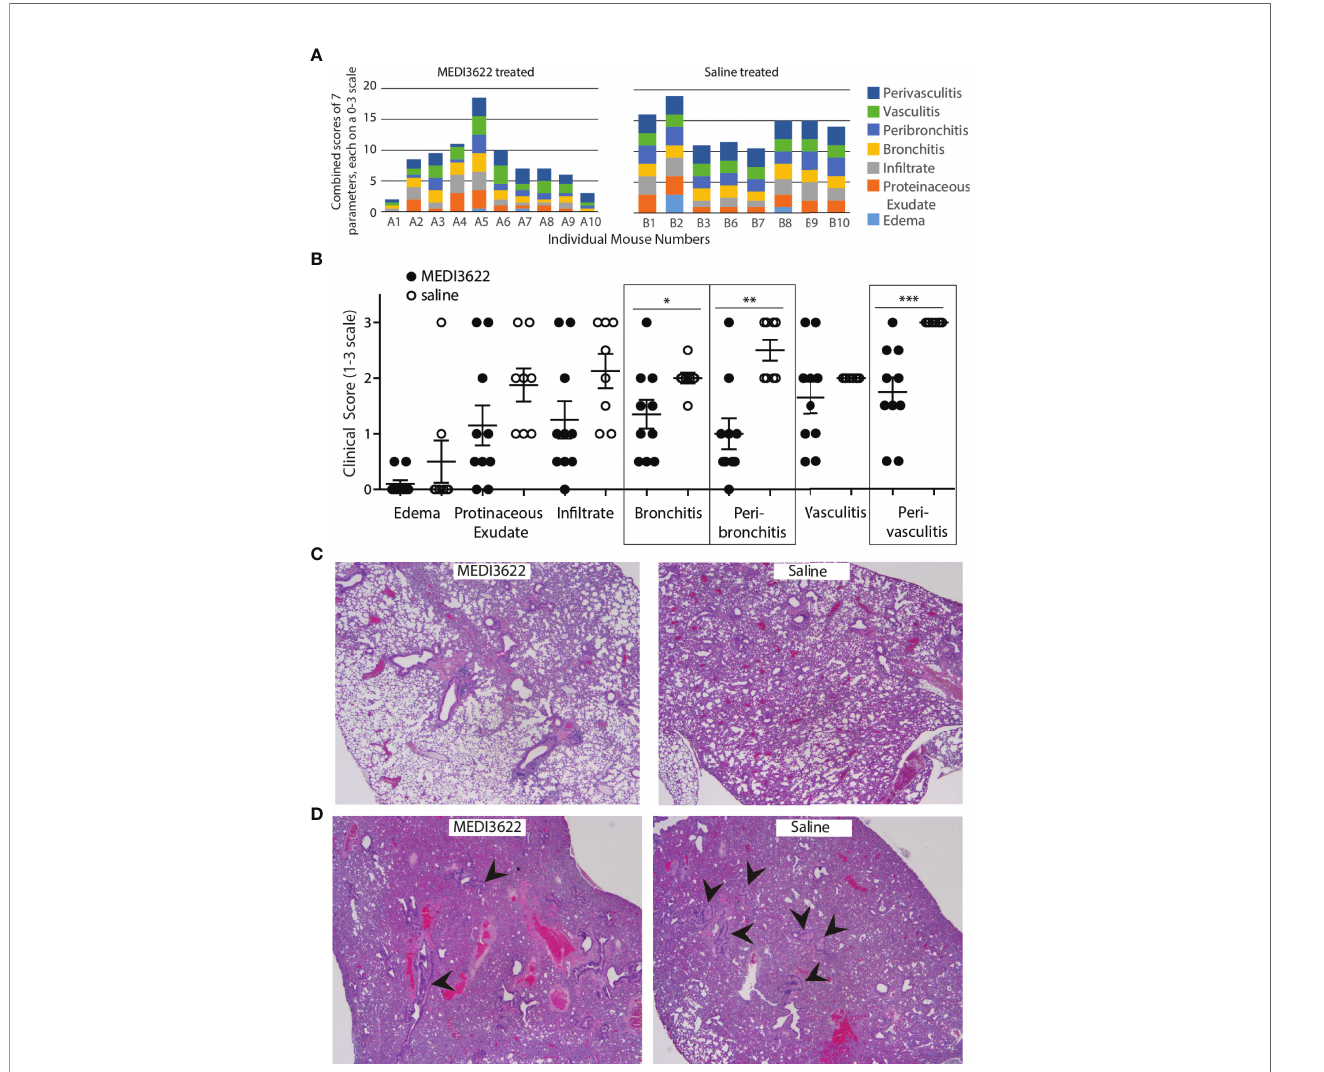
FIGURE 2 | Damage to lungs in MEDI3622-treated SARS-CoV-2 infected mice is signi fi cantly reduced compared to those treated with saline. (A) Histological scores from parameters shown on right were assessed on a 0-3 scale for each parameter for each mouse. (B) Histological scores for each parameter listed in (A) are shown. Mann-Whitney test *p<0.05, **p<0.01, ***p<0.001. (C) Representative sections from each treatment group show differences in lung damage. (D) More mice in the saline-treated group (7 out of 8) had collapsed and fl uid fi lled large bronchi (arrowheads point to examples) than in the MEDI3622-treated group (3 out of 10). This experiment was performed similarly 2 independent times with 10 mice per group. The lung section from the most severely in fl amed MEDI3622-treated mouse has fewer collapsed bronchi compared to a representative example from the saline-treated